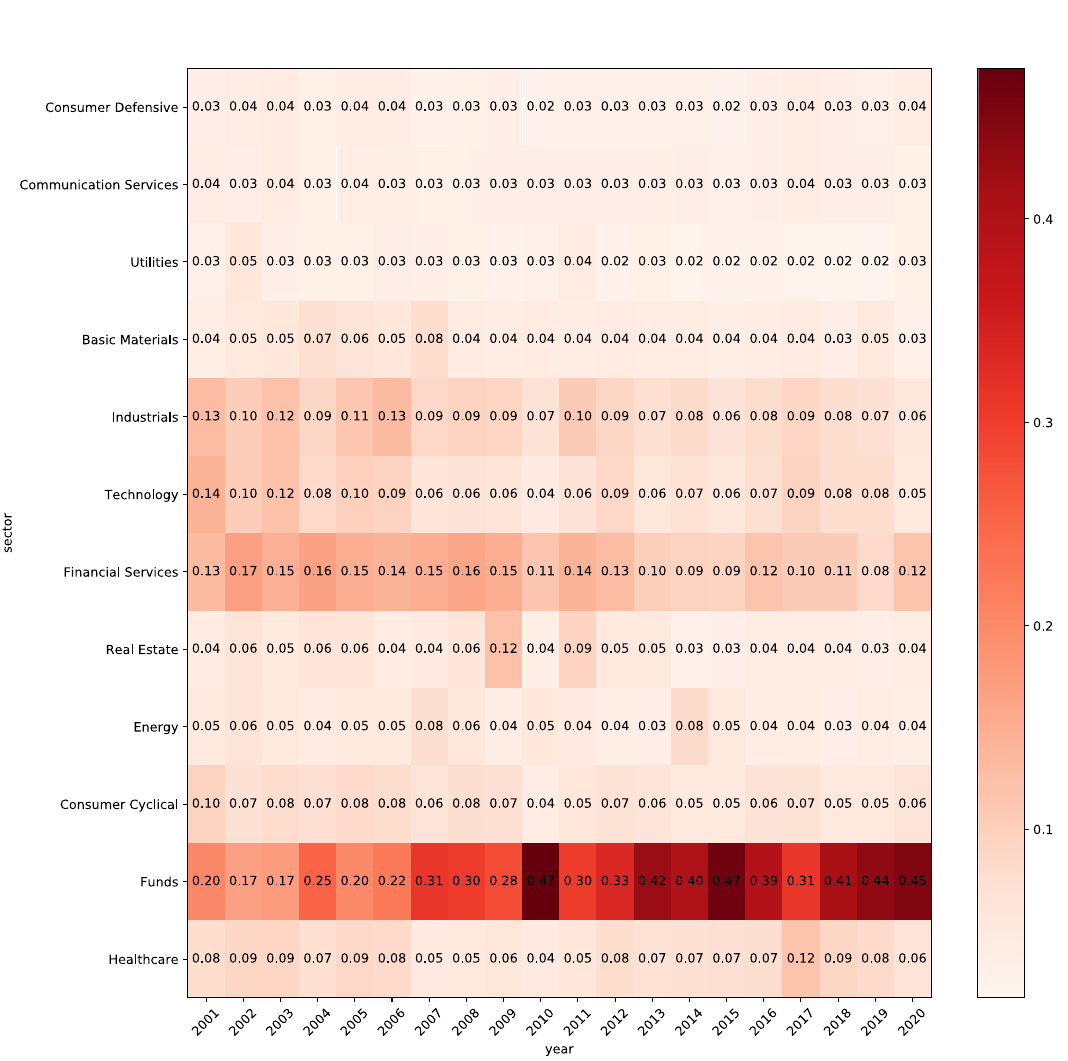
Figure 5: Breakdown of the most in fl uential market sectors for each time period based on the PageRank